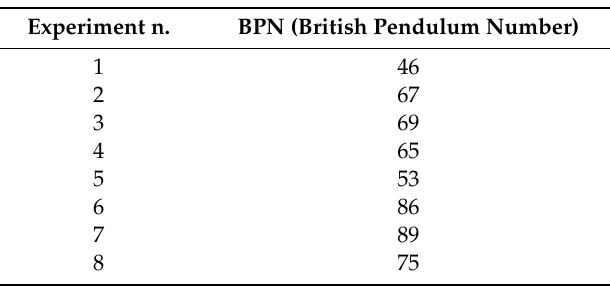
Table 10. Values of BPN for the mixtures of Table 5. Experiment n.